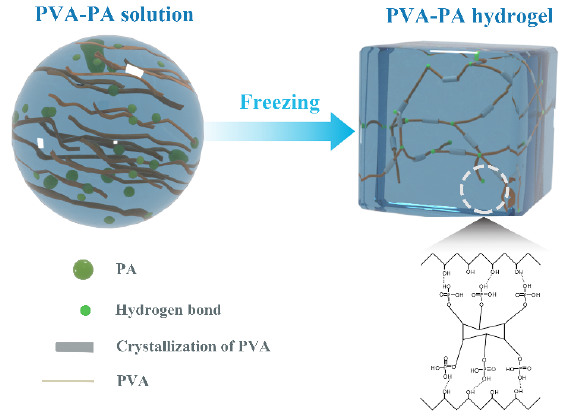
Figure 5. Synthesis mechanism diagram of PVA-PAx hydrogel.